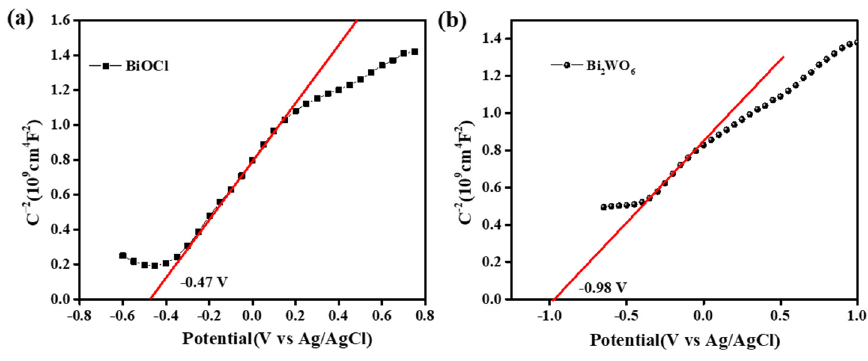
Figure 13. The TRPL spectra of pure BiOCl, Bi 2 WO 6 , and Bi 2 WO 6 /BiOCl nanocomposites. The Mott–Schottky plots of the samples are shown in Figure 14. The flat-band potential (E fb ) could be determined based on the Mott–Schottky curves [16,47]. The positive slope of the curves suggests that the BiOCl and Bi 2 WO 6 are n-type semiconductor. Notably, the E fb values of BiOCl and Bi 2 WO 6 were determined to be − 0.47 and − 0.98 V (vs. Ag/AgCl), respectively. Therefore, the CB potential values of the BiOCl and Bi 2 WO 6 were − 0.25 and − 0.76 V (vs. NHE, pH = 7), respectively [23,31]. Based on these results, the valence band (VB) positions were determined to be 3.06 and 1.90 V. These results indicate that the construction of a heterostructure interface between the BiOCl and Bi 2 WO 6 can significantly improve photoinduced carrier separation efficiency and photocatalytic efficiency due to the matching energy levels.